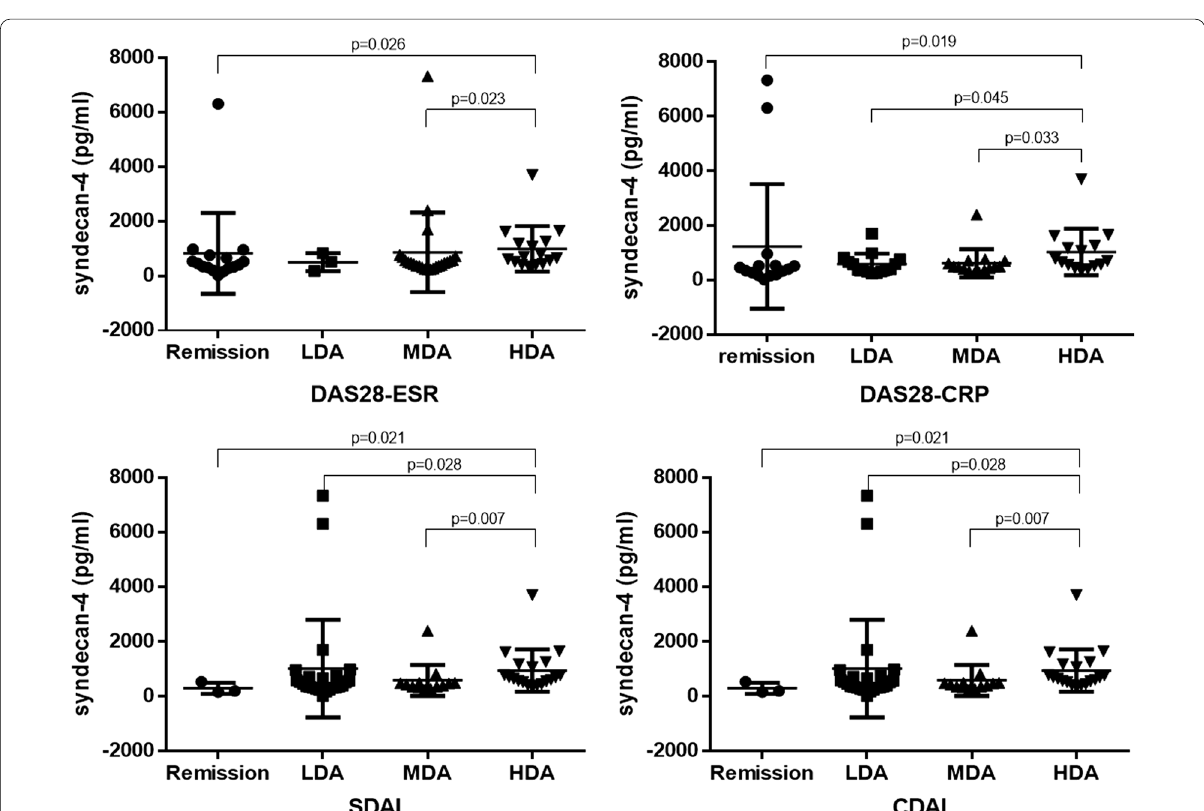
Fig. 3 The comparison of serum syndecan-4 between sera-positive and sera-negative RA patients. RA: rheumatoid arthritis. RF: rheumatoid factor; anti-CCP: anti-cyclic citrullinated